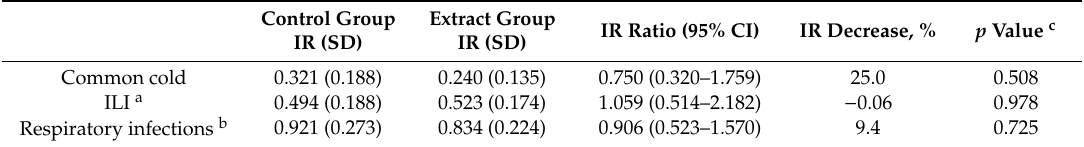
Table 2. Incidence of respiratory tract